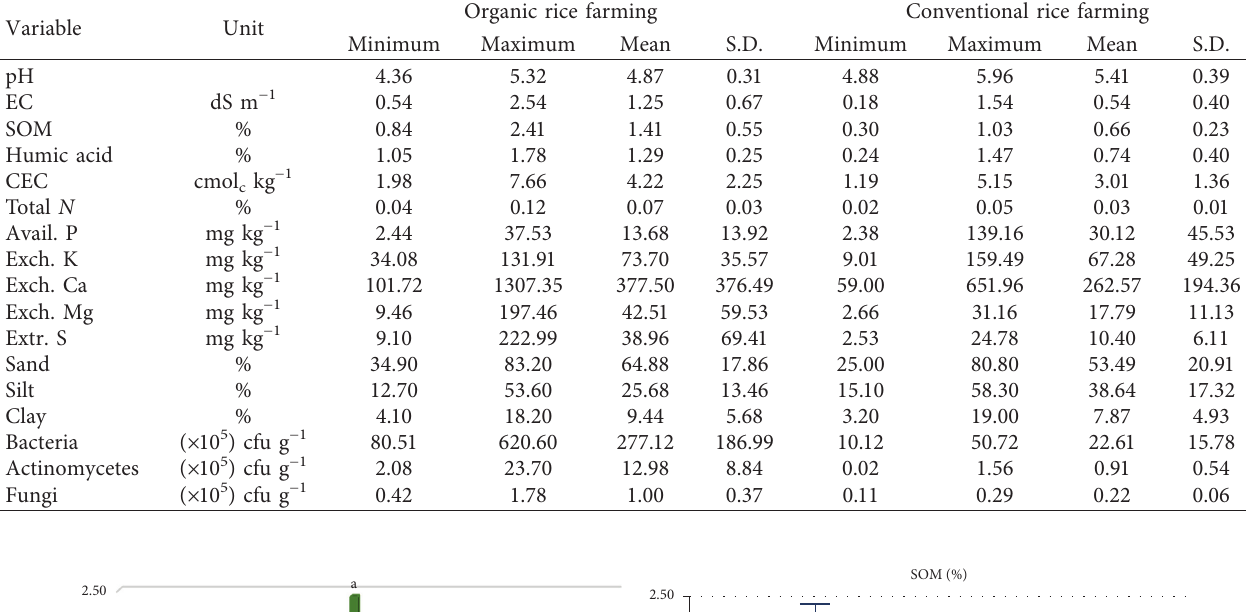
Table 1: Statistical summary of the physicochemical properties and microbial population of the soil for organic and conventional rice farming systems.